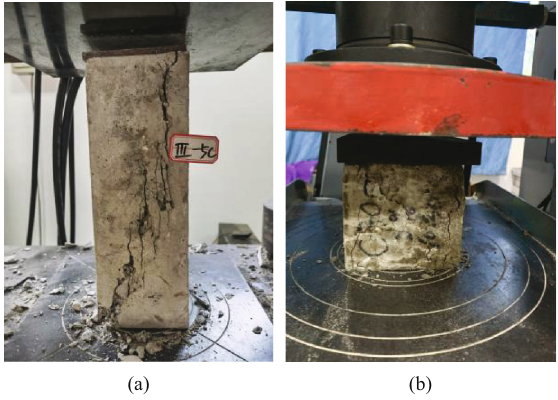
Figure 3: Pouring and vibrating of test block.